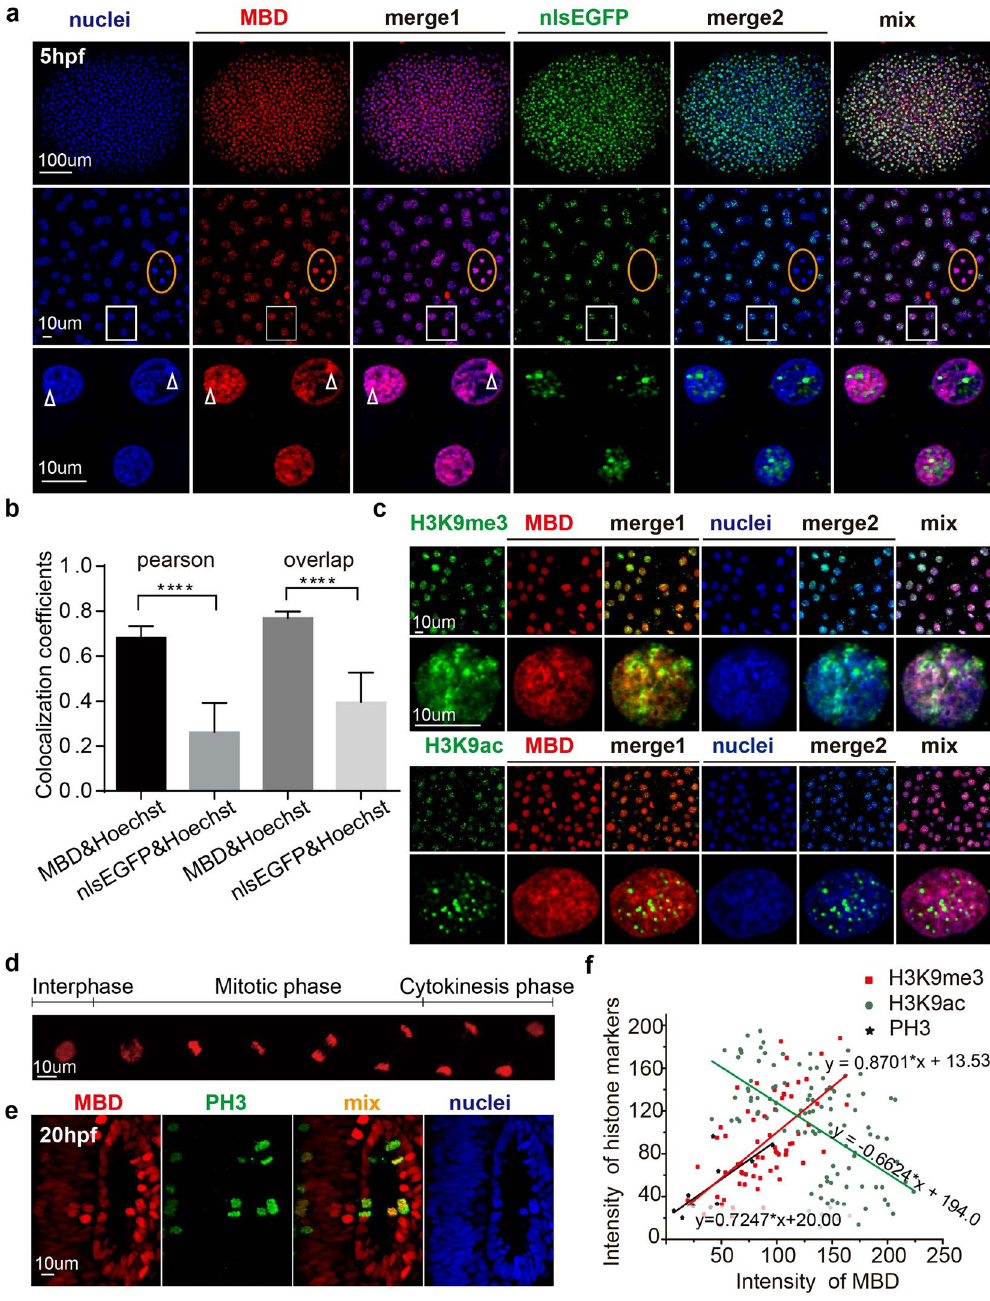
Figure 2. Colocalization of mCherry-MBD with heterochromatin and modified histones. ( a ) The correlation between Hoechst staining and the distribution patterns of the probes in 5 hpf embryos. Higher magnification images are arranged below. The orange boxes denote cells in mitotic metaphase; note that the nlsEGFP signal has disappeared due to nuclear envelope breakdown. White boxes below show magnified images. White arrowheads label puncta in Hoechst-stained nuclei. ( b ) Columns represent the overlap and Pearson coefficients for colocalization between Hoechst and the probes. P values < 0.0001, N = 27. ( c ) The colocalization pattern of mCherry-MBD and H3K9me3/ac. Lower rows showed subcelluar structure in one single cell nuclei. ( d ) Time lapse imaging of mCherry-MBD dynamics during the cell cycle. ( e ) The distribution of mCherry-MBD in phospho-Histone H3-positive metaphase cells. ( f ) The linear regression analysis between the intensity of MBD and that of modified histones. The plots represent cells or ROIs (region of interest) selected by image j (H3K9me3, N = 66 ROIs; H3K9ac, N = 112 ROIs; PH3, N = 10 cells). The intensity value ranged from 0 to 255. P value <